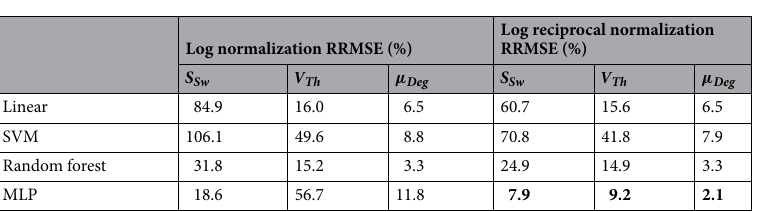
Table 1. Performance comparison between log normalization and log reciprocal normalization for the prediction of the secondary properties using various machine learning models. Significance values are given in bold. The RRMSE metric is used for the